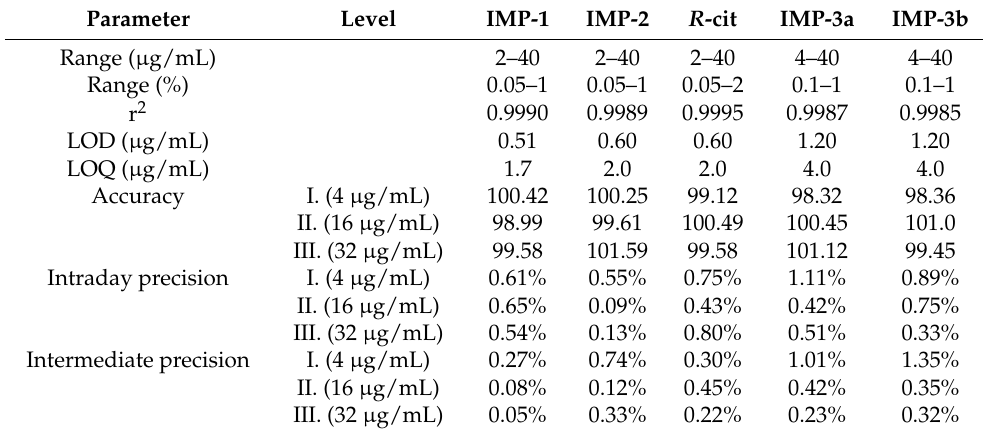
Table 3. Summary of data obtained during method validation for the simultaneous determination of related substances and enantiomeric